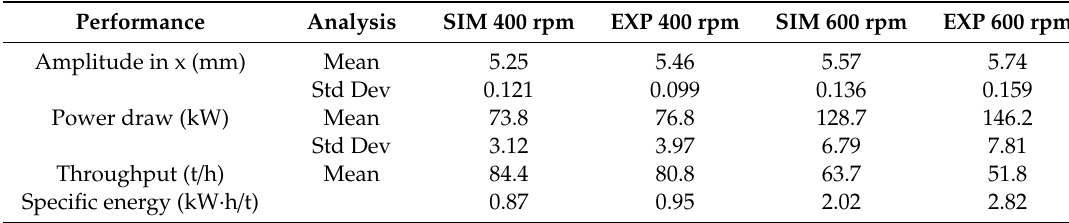
Table 5. Summary of simulated and experimental averaged